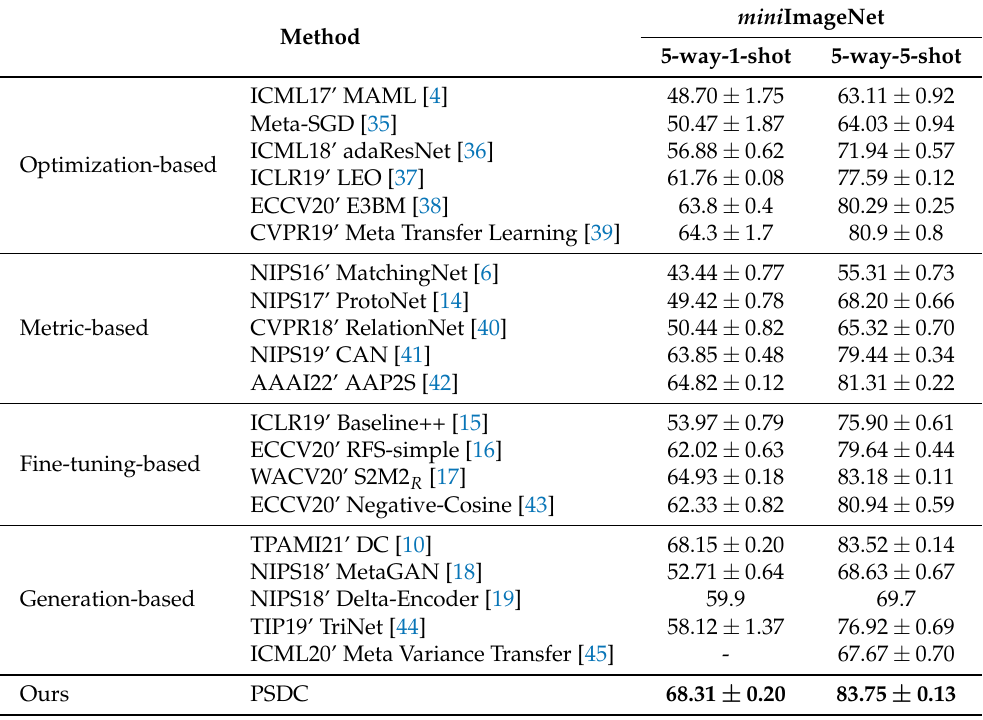
Table 1. 5-way-1-shot and 5-way-5-shot classification accuracy (%) on mini ImageNet with 95% confidence